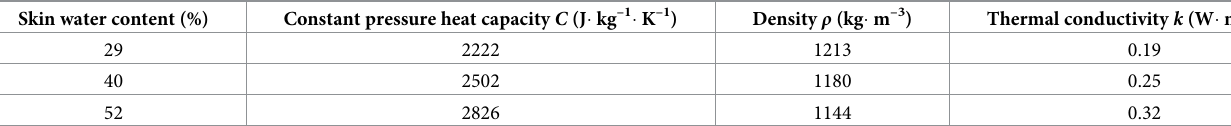
Table 3. Values of skin thermal physical parameters.